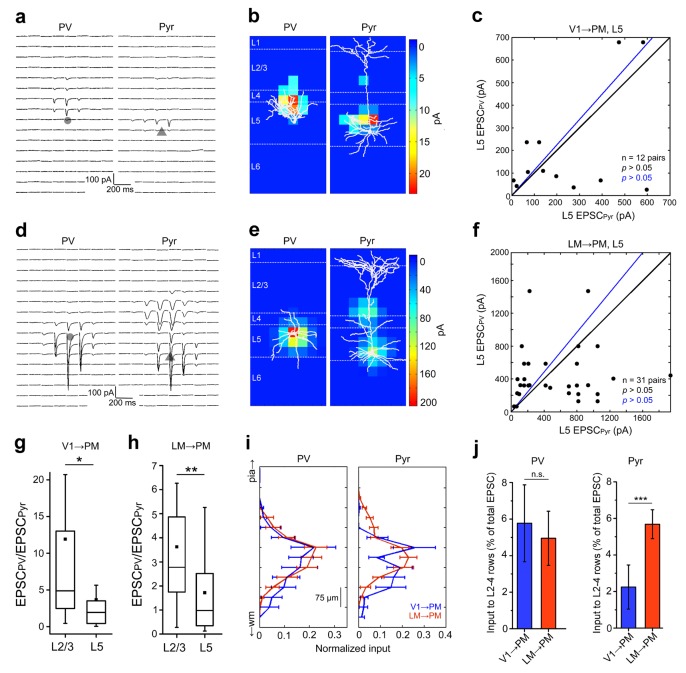
FF input to L5 neurons.(a) FFV1→PM EPSCssCRACM in a pair of neighboring L5 PV (left) and Pyr (right) cells. (b) Heat map of EPSCs in 6a superimposed with respective biocytin-filled L5 neurons. (c) Scatter plot, as previously described, of EPSCssCRACM in PV and Pyr cell pairs in L5 FFV1→PM. The total current in PV and Pyr cells were not significantly different. (d–f) Similar data as in Figure 6a—c but for L5 FFLM→PM. (g,h) PV cell excitation, normalized to the excitation of a neighboring Pyr cell, is stronger in L2/3 than in L5 for both V1→PM (g) and LM→PM pathways (h). (i) Total EPSC in each row of the 8 × 16 grid normalized to total current recorded, plotted against row position (16 rows). Note that L5 PV cells do not show significant differences in the laminar distribution of EPSCs in the two pathways, but L5 Pyr cells receive more input in the upper layers from LM than from V1. (j) Interareal input in L2-4 for L5 PV cells (left) in PM is not significantly different for the two pathways. L5 Pyr cells (right) receive more L2-4 input in the FFV1→PM than in the FFLM→PM pathway. L2-4 input calculated as the average EPSC in each row that resided in L2-4, shown as the percentage of the total EPSC in the cell (***p<0.001, Mann-Whitney U-test).